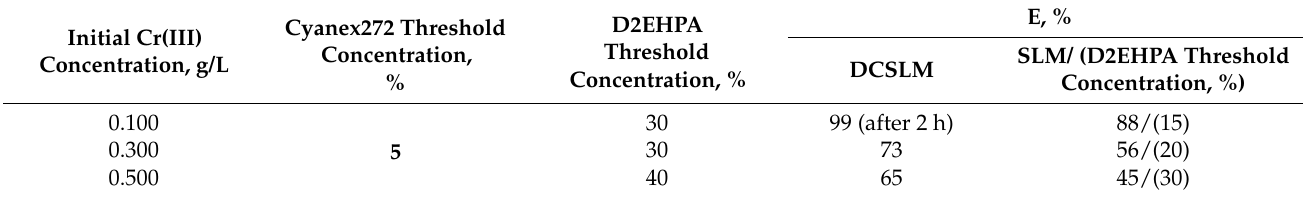
Table 10. Effect of the optimum carrier proportion on the Cr(III) ions extraction in DCSLM compared to SLM. Concentration of the D2EHPA was selected on the basis of the RSM